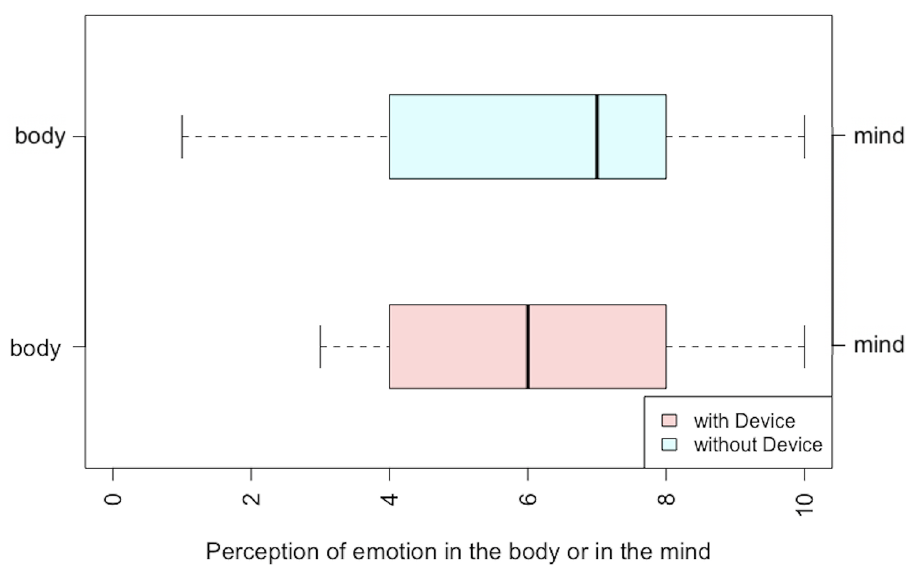
Figure 3. Perception of the felt emotion (in the body or in the mind) reported by the participants.